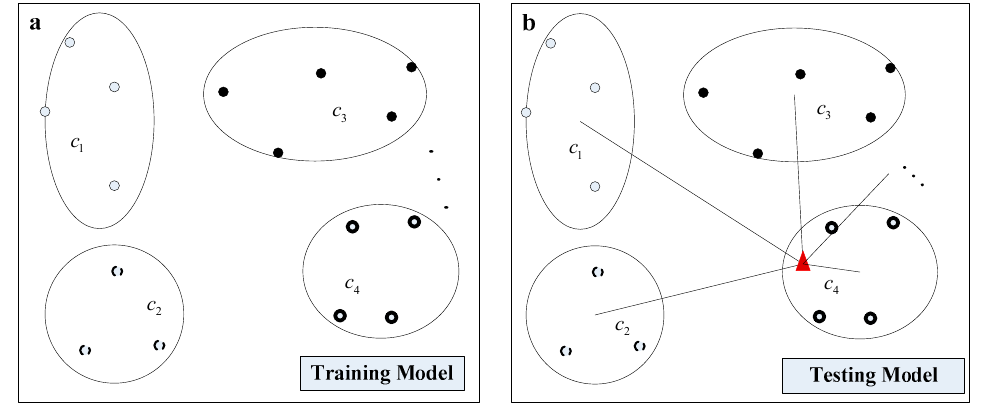
Figure 3. Two procedures for the variety classification ( a ) The training of the model by the labelled samples, ( b ) variety reorganization for the test data. The four ellipses represent four varieties, the other four varieties are omitted in the figure. The red point in Figure 3b represents the seeds of one of the eight varieties, which was prepared for reorganization.